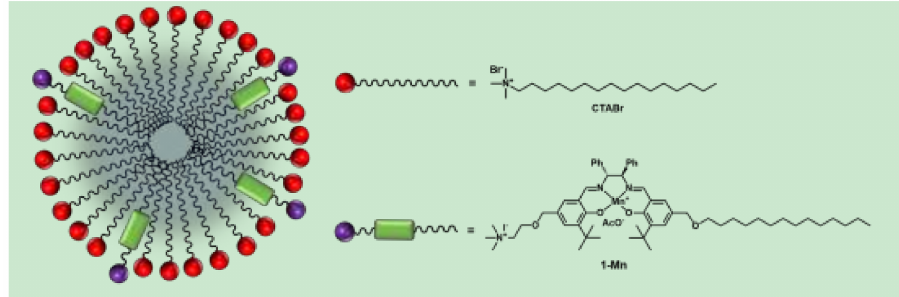
Figure 1. Schematic representation of the micellar nanoreactor and chemical structure of the catalyst 1-Mn and